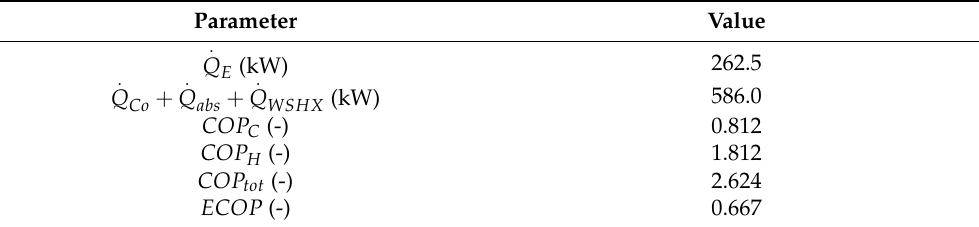
Table 4. Absorption heat pump performance for 4th Generation